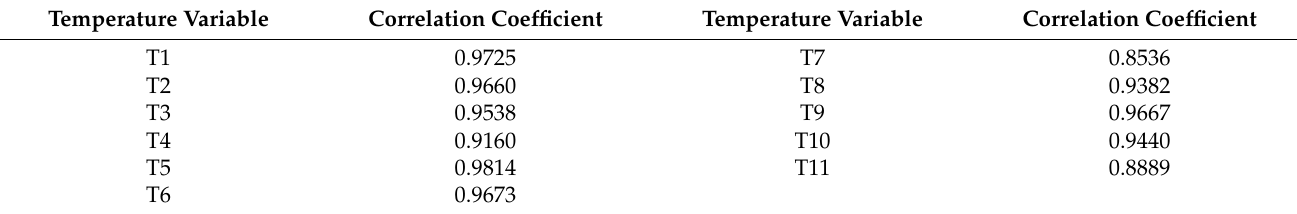
Table 4. The correlation coefficients between temperature variables and slope k i .